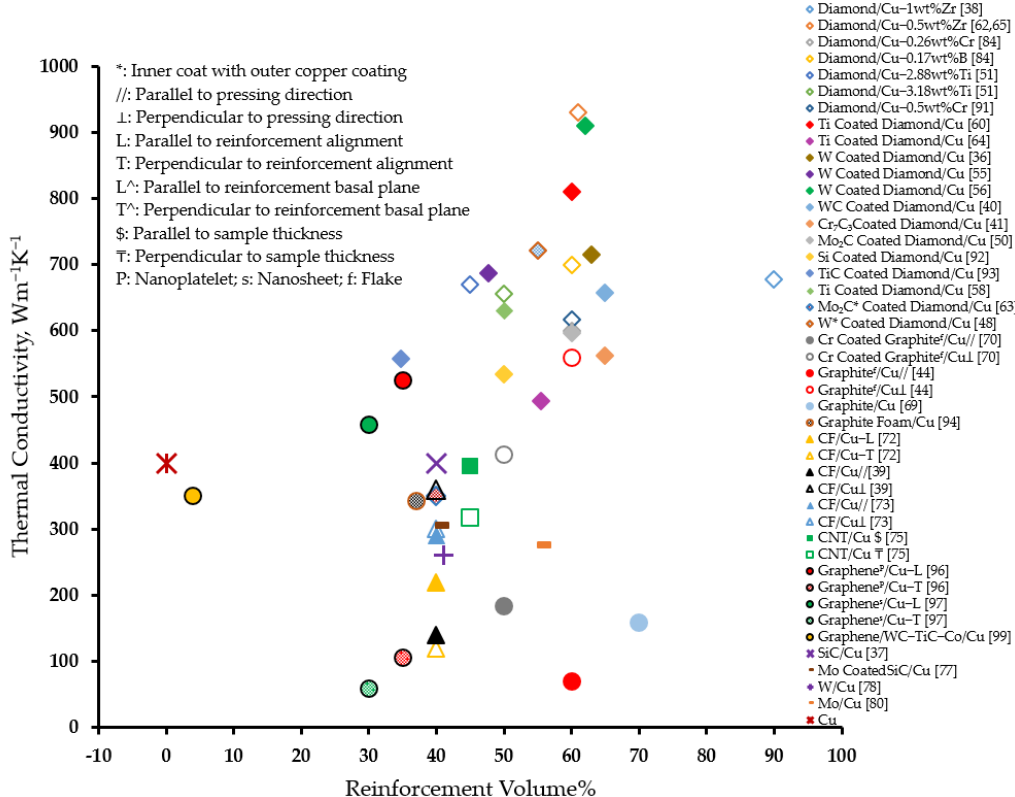
Figure 5. Effect of reinforcement on the thermal conductivity of copper matrix composites.